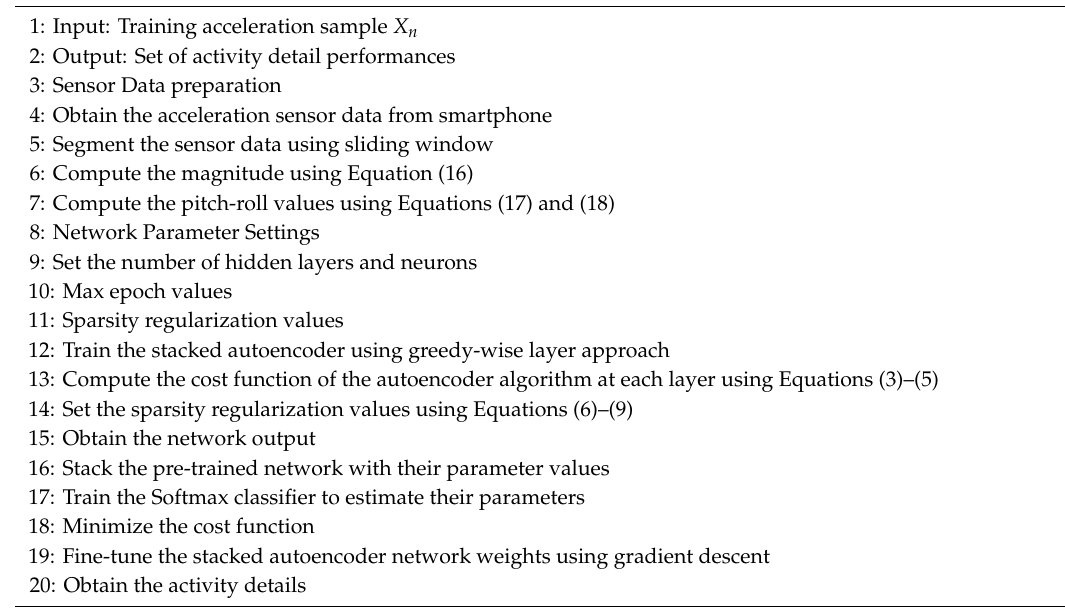
Algorithm 1. Deep learning-based complex activity identification training